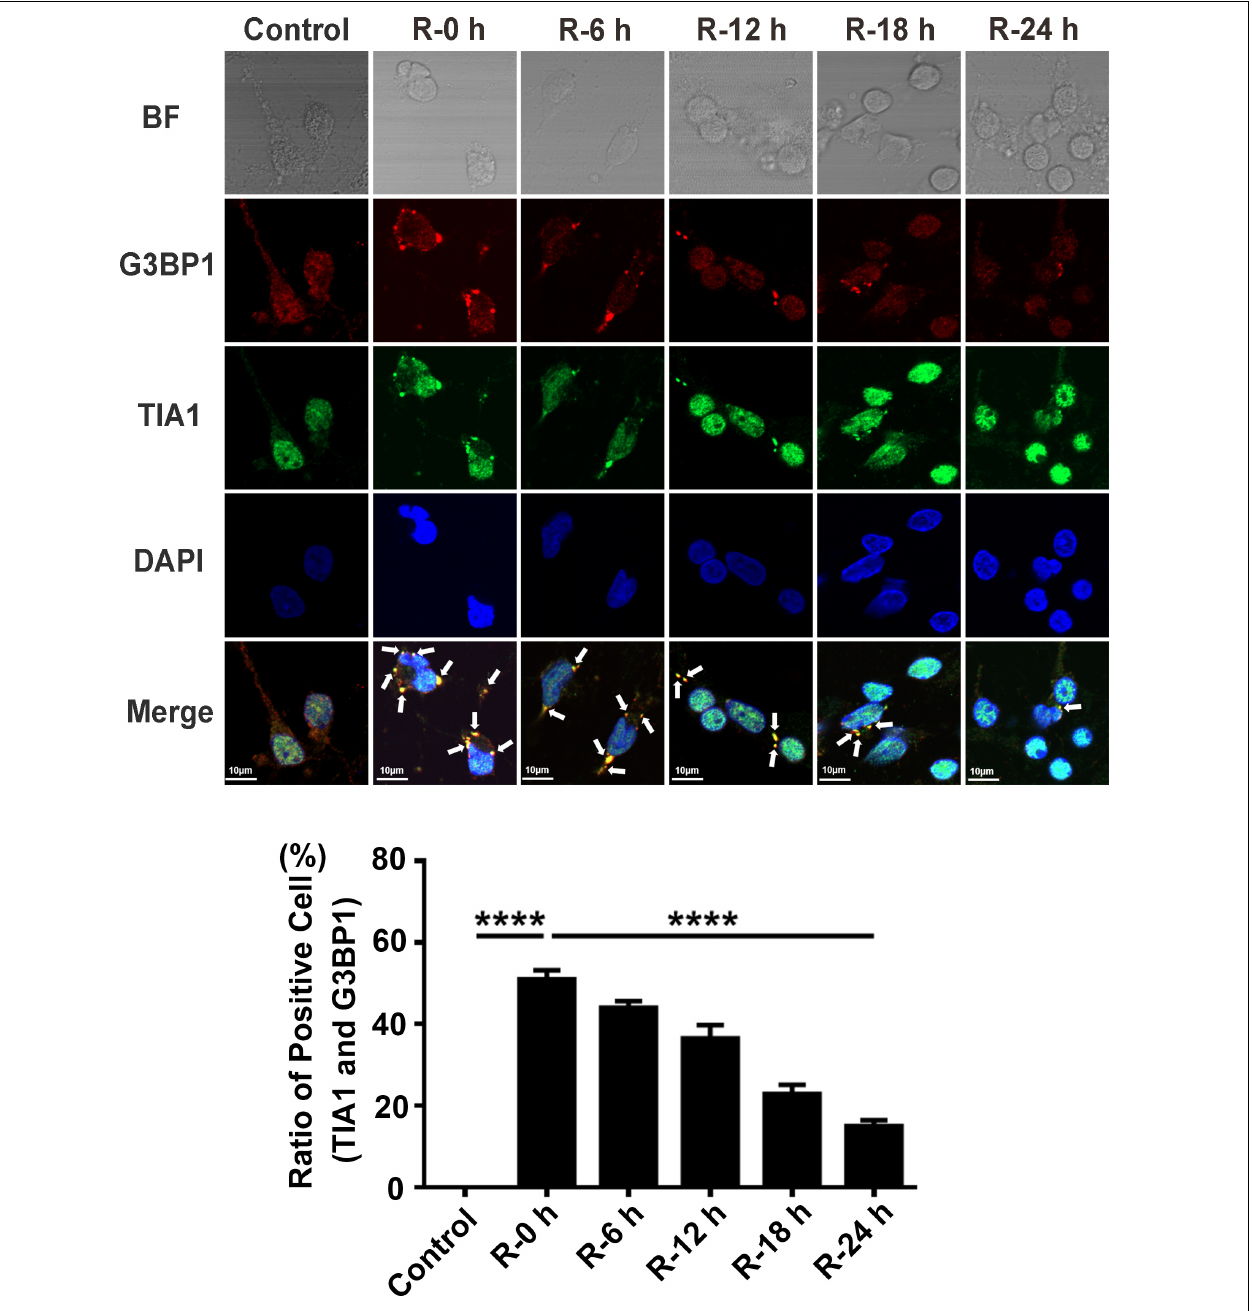
FIGURE 1 | The dynamic generation of SGs at different time points of reperfusion under OGD/R condition in rat primary cortical neurons. SG formation of rat primary cortical neurons was detected with double-labeled immunofluorescence (TIA1 and G3BP1) at 0, 6, 12, 18, and 24 h reperfusion after 6 h OGD stimulation. **** , compared with R-0 h group; P < 0.0001. SGs were labeled with TIA1 (green) and G3BP1 (red), and the nucleus was labeled with DAPI (blue). Scale bars: 10 µ